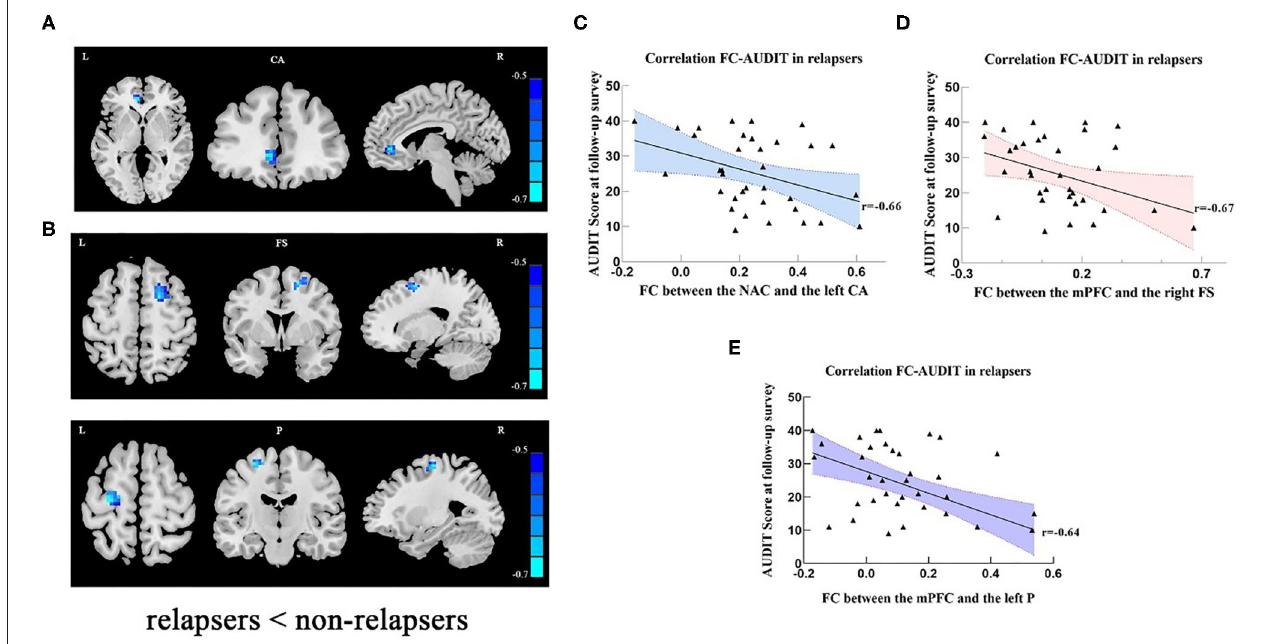
FIGURE 2 | (A) In relapse cases, lower FC was detected in left cingulate anterior cortex (seed: NAC). (B) In relapse cases, lower FC was detected in right frontal superior and left precentral areas (seed: mPFC). The scatter plots show that relapse severity was negatively associated with FC between NAc and left CA (C) , FC between mPFC and right FS (D) , and FC between the mPFC and left P (E) . Clusters were labeled with the Automated Anatomical Labeling (AAL) atlas. The t maps were drawn with a threshold of p < 0.001 at the voxel level and P FWE < 0.05 at the cluster level. The color bar indicates voxel-wise t values. lower FC is shown in blue. The brighter the blue, the lower the FC. FC, functional connectivity; NAc, nucleus accumbens; mPFC, medial prefrontal cortex; L, left; R, right; CA, cingulum anterior; FS, frontal superior gyrus; P, precentral; AUDIT, alcohol use disorder identification test.